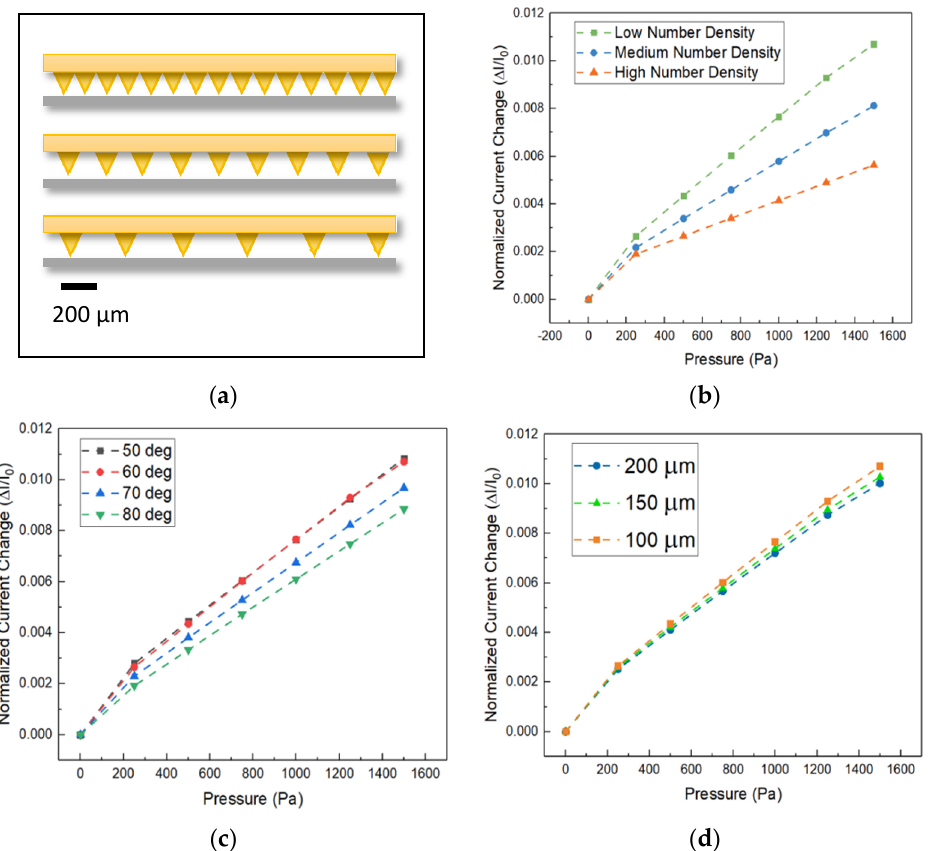
Figure 4. Schematic of different spatial densities under investigation ( a ). Micro-pyramid geometric parameter and configuration results in terms of relative current as a function of applied pressure for ( b ) different spatial densities, ( c ) different pyramid angles “ α ”, ( d ) different pyramid size “ (cid:96)